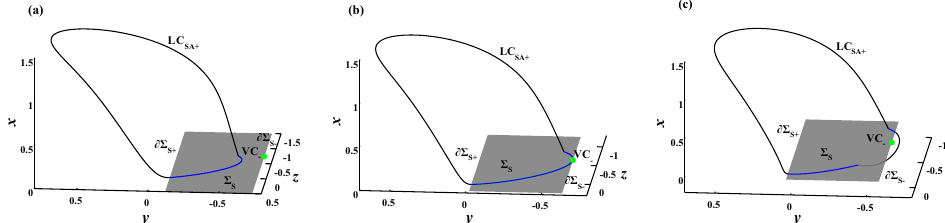
Figure 5. The multi-sliding bifurcation geometry of limit cycle LC SA + , where the dark-gray region denotes sliding region Σ S and the sliding segments are colored in blue. ( a ) w = 0.7; ( b ) w ≈ 0.533; ( c ) w = 0.45.